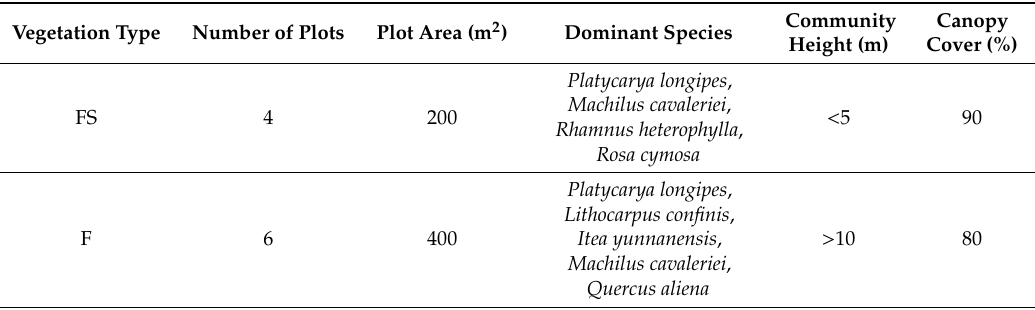
Table 1. Description of the two types of vegetation.